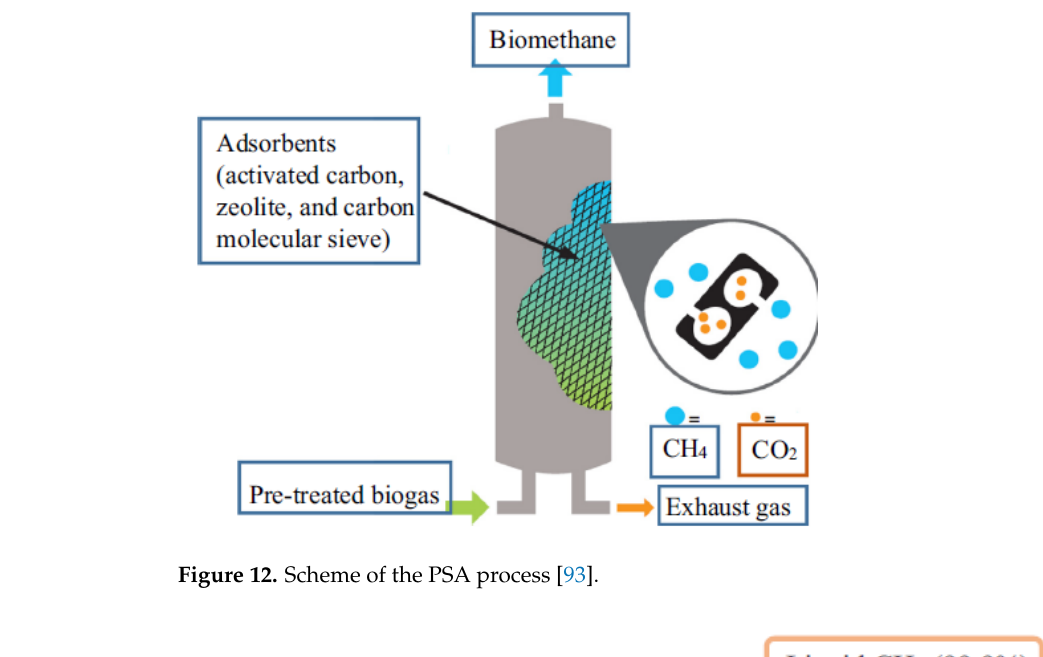
Figure 12. Scheme of the PSA process [93].